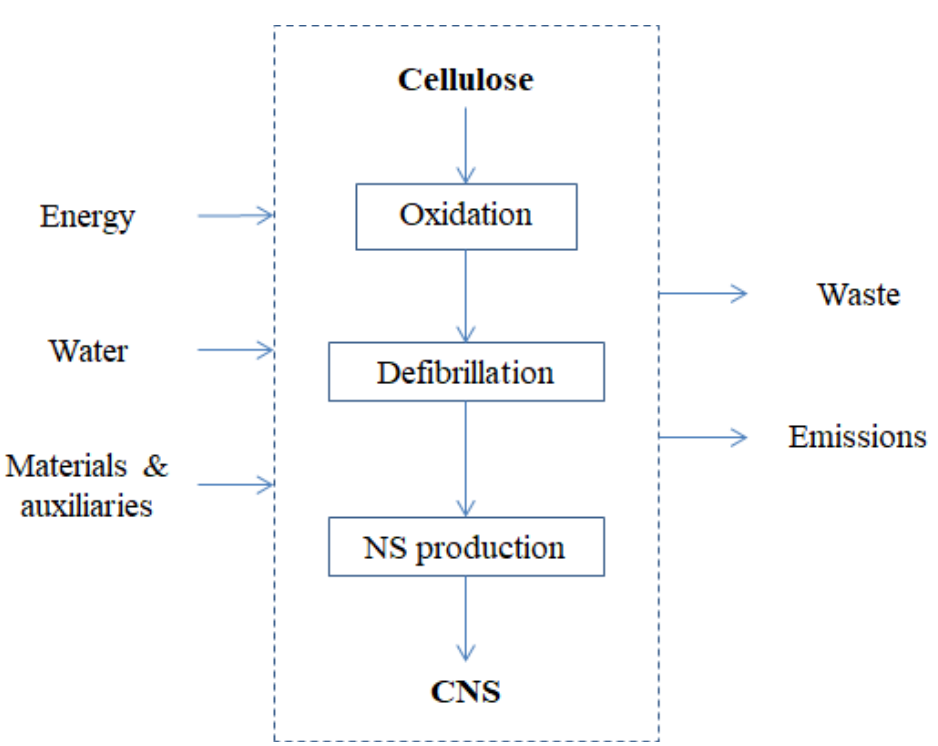
Figure 4. System boundaries and input and output flows considered in the LCA analysis of CNS.